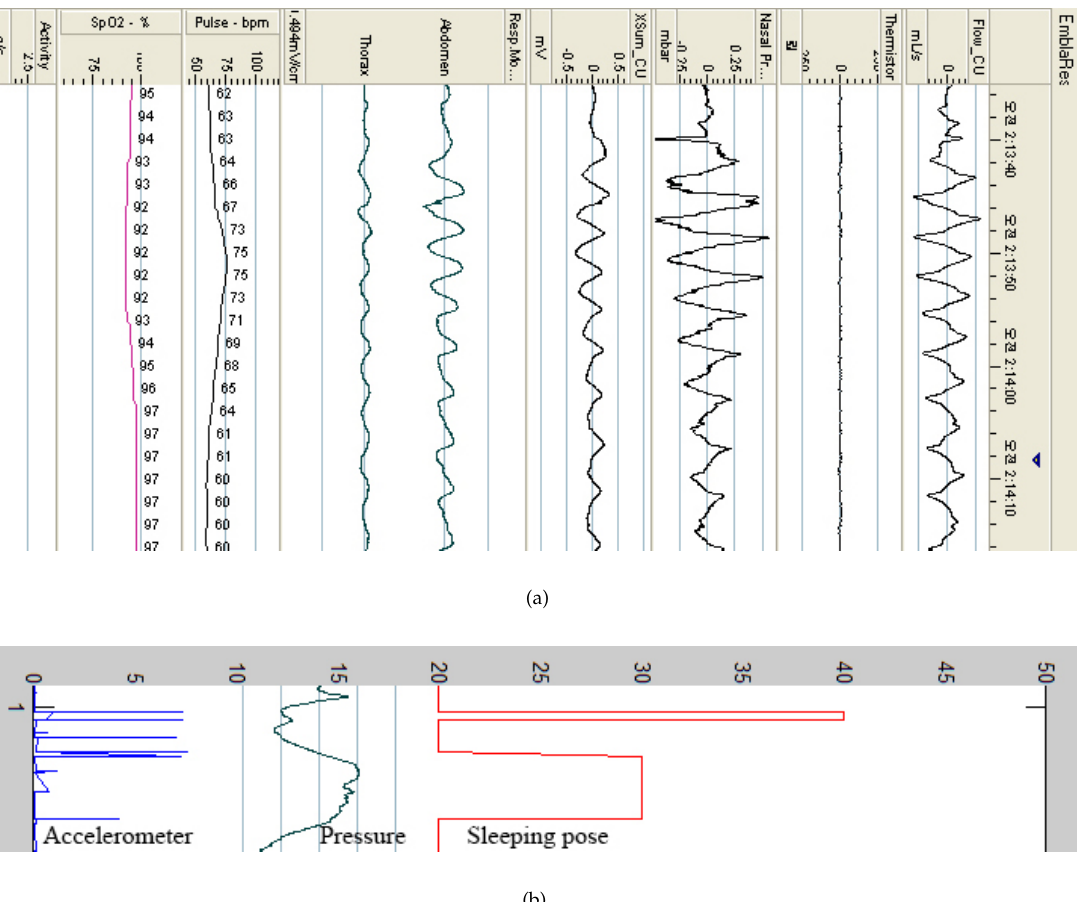
Figure 12. Example of signals obtained from sensors in the presence of motion artifact. ( a ) Example of signals obtained from the PSG in the presence of motion artifact; ( b ) Example of signals obtained from an accelerometer sensor and a pressure sensor in the presence of motion